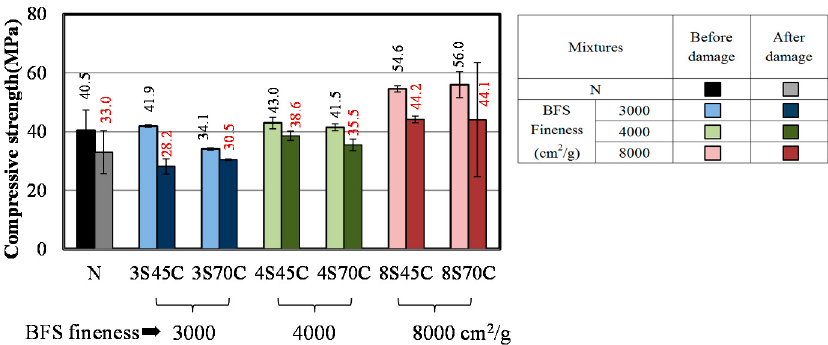
Figure 9. Changes of compressive strength in different mortar samples.